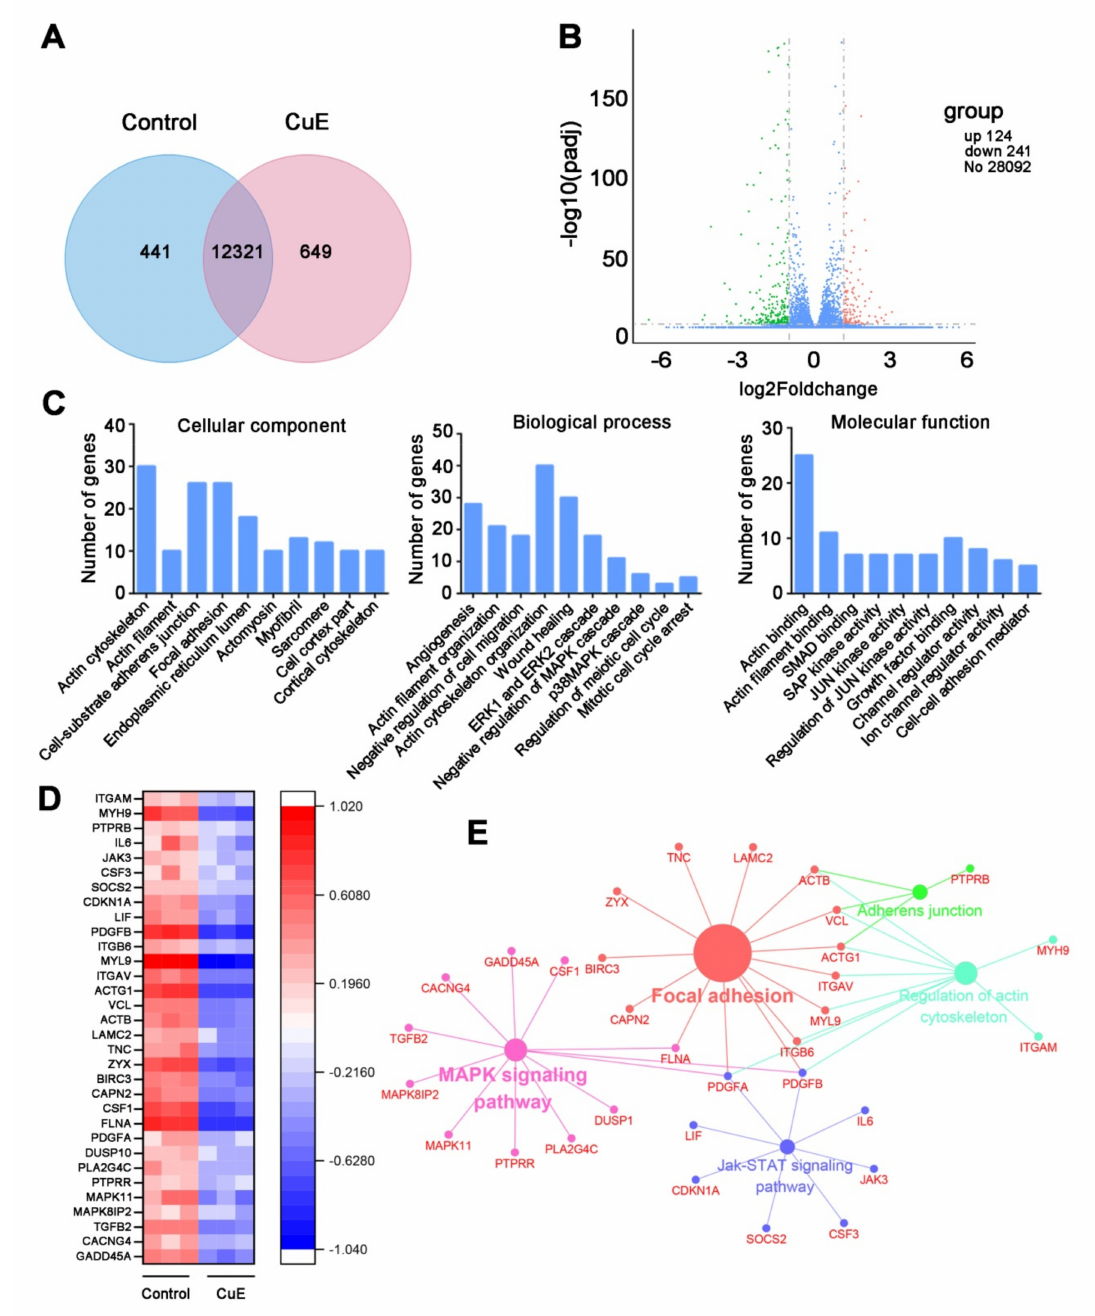
Figure 2. RNA-seq analysis for CuE-altered genes. Cells were treated with vehicle, or 40 nM of CuE for 24 h, respectively. ( A ) Venn diagram showing numerical distribution of di ff erentially expressed genes in HUh7 cells. ( B ) The volcano of di ff erentially expressed genes. ( C ) Genes significantly down-regulated by CuE were classified into di ff erent CCs, BPs, and MFs. ( D ) Heat map of down-regulated genes involved in significantly canonical pathways after treatment with CuE in Huh7 cells. ( E ) KEGG pathway enrichment analysis for the significantly down-regulated gene predicted the significantly canonical